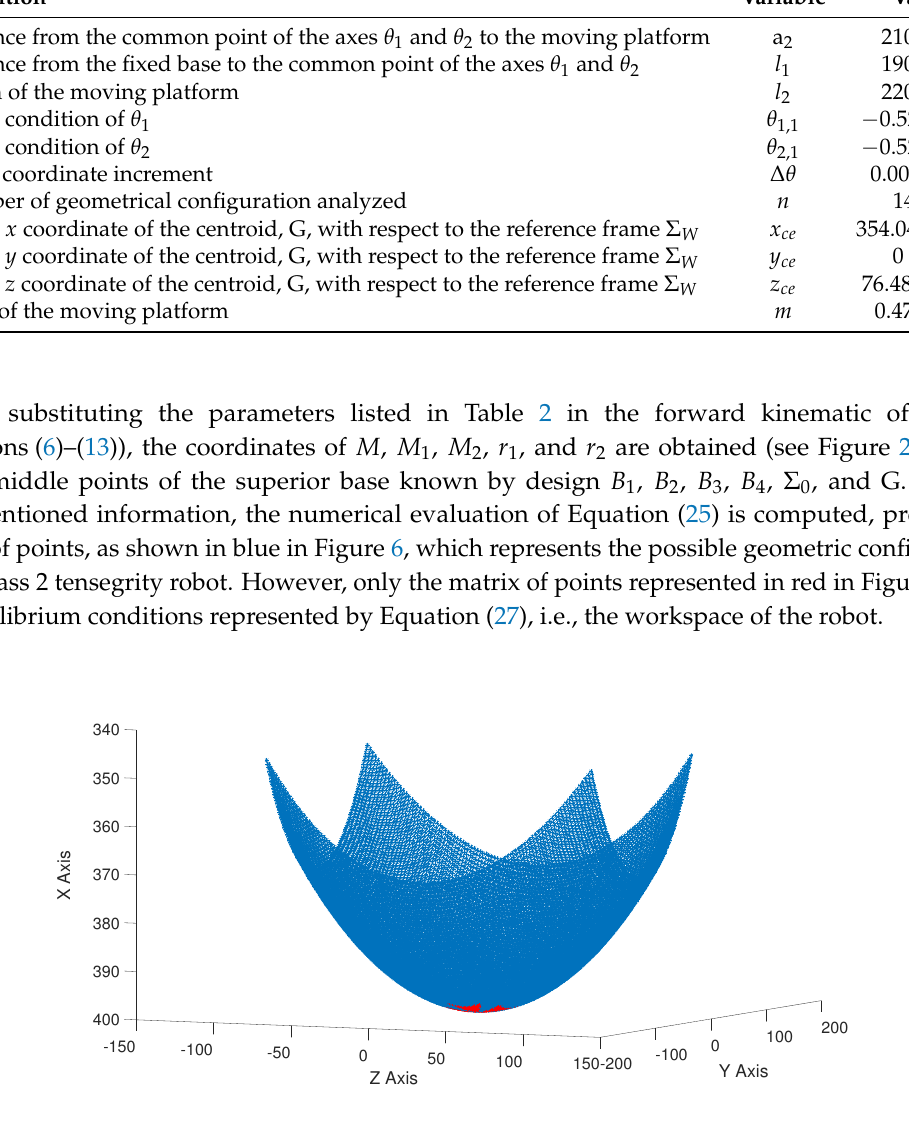
Figure 6. Three-dimensional workspace of the class 2 tensegrity